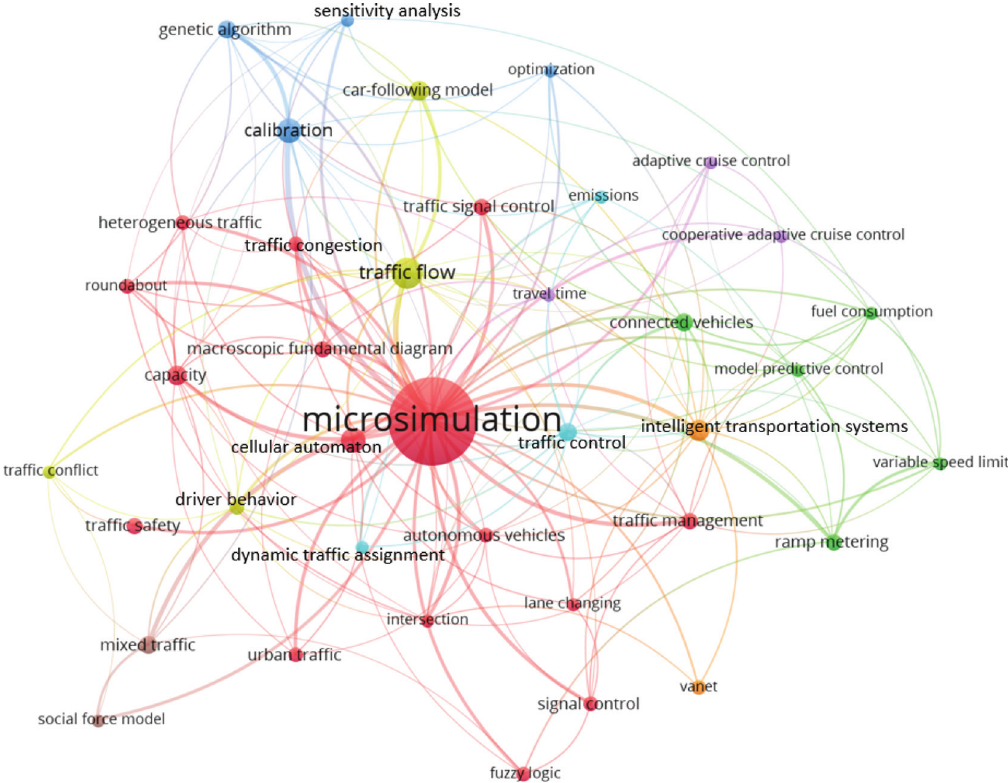
Figure 1: Keyword network from traffic microsimulation Table 1: Adopted nomenclature in the study.